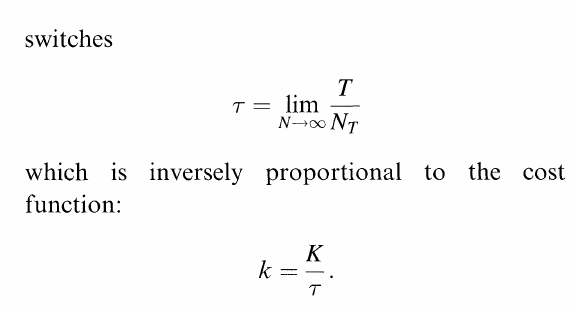
FIGURE 3 Lower panel: The Poincar6 map for the three- funnel model with the production rates Ul =0.5, u2 =0.3 and u3 0.2. Sn and Sn +1 are the successive reflection points of the triangle circumference coordinate S. The small circles represent the period-3 orbit that minimizes the cost function. Upper panel: the invariant probability distribution.